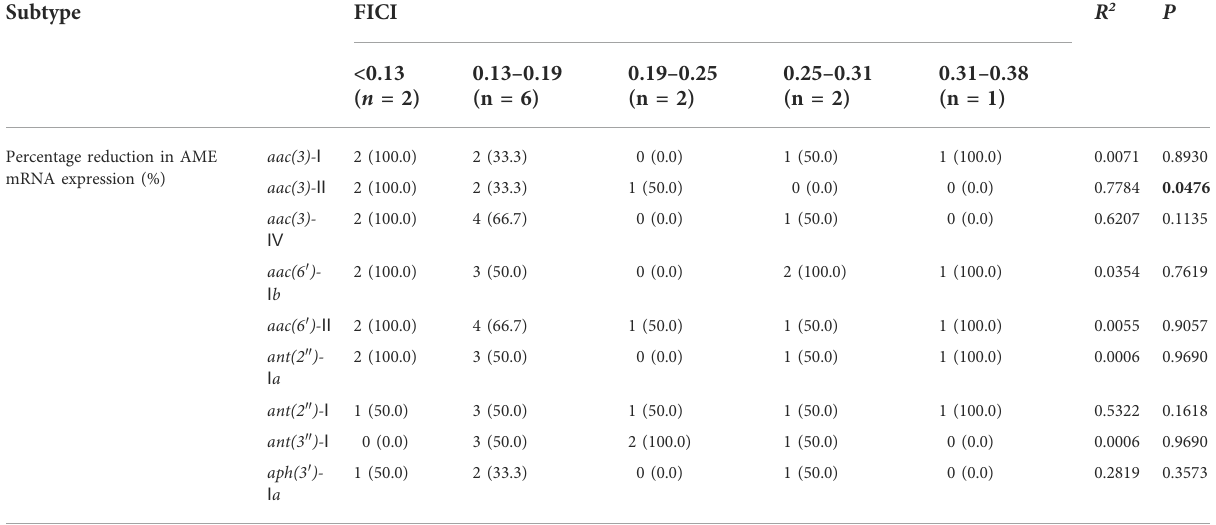
TABLE 6 Correlation analysis between fractional inhibitory concentration index (FICI) values and mRNA expression of aminoglycoside-modifying enzymes (AMEs) in 13 clinical isolates of Pseudomonas aeruginosa .